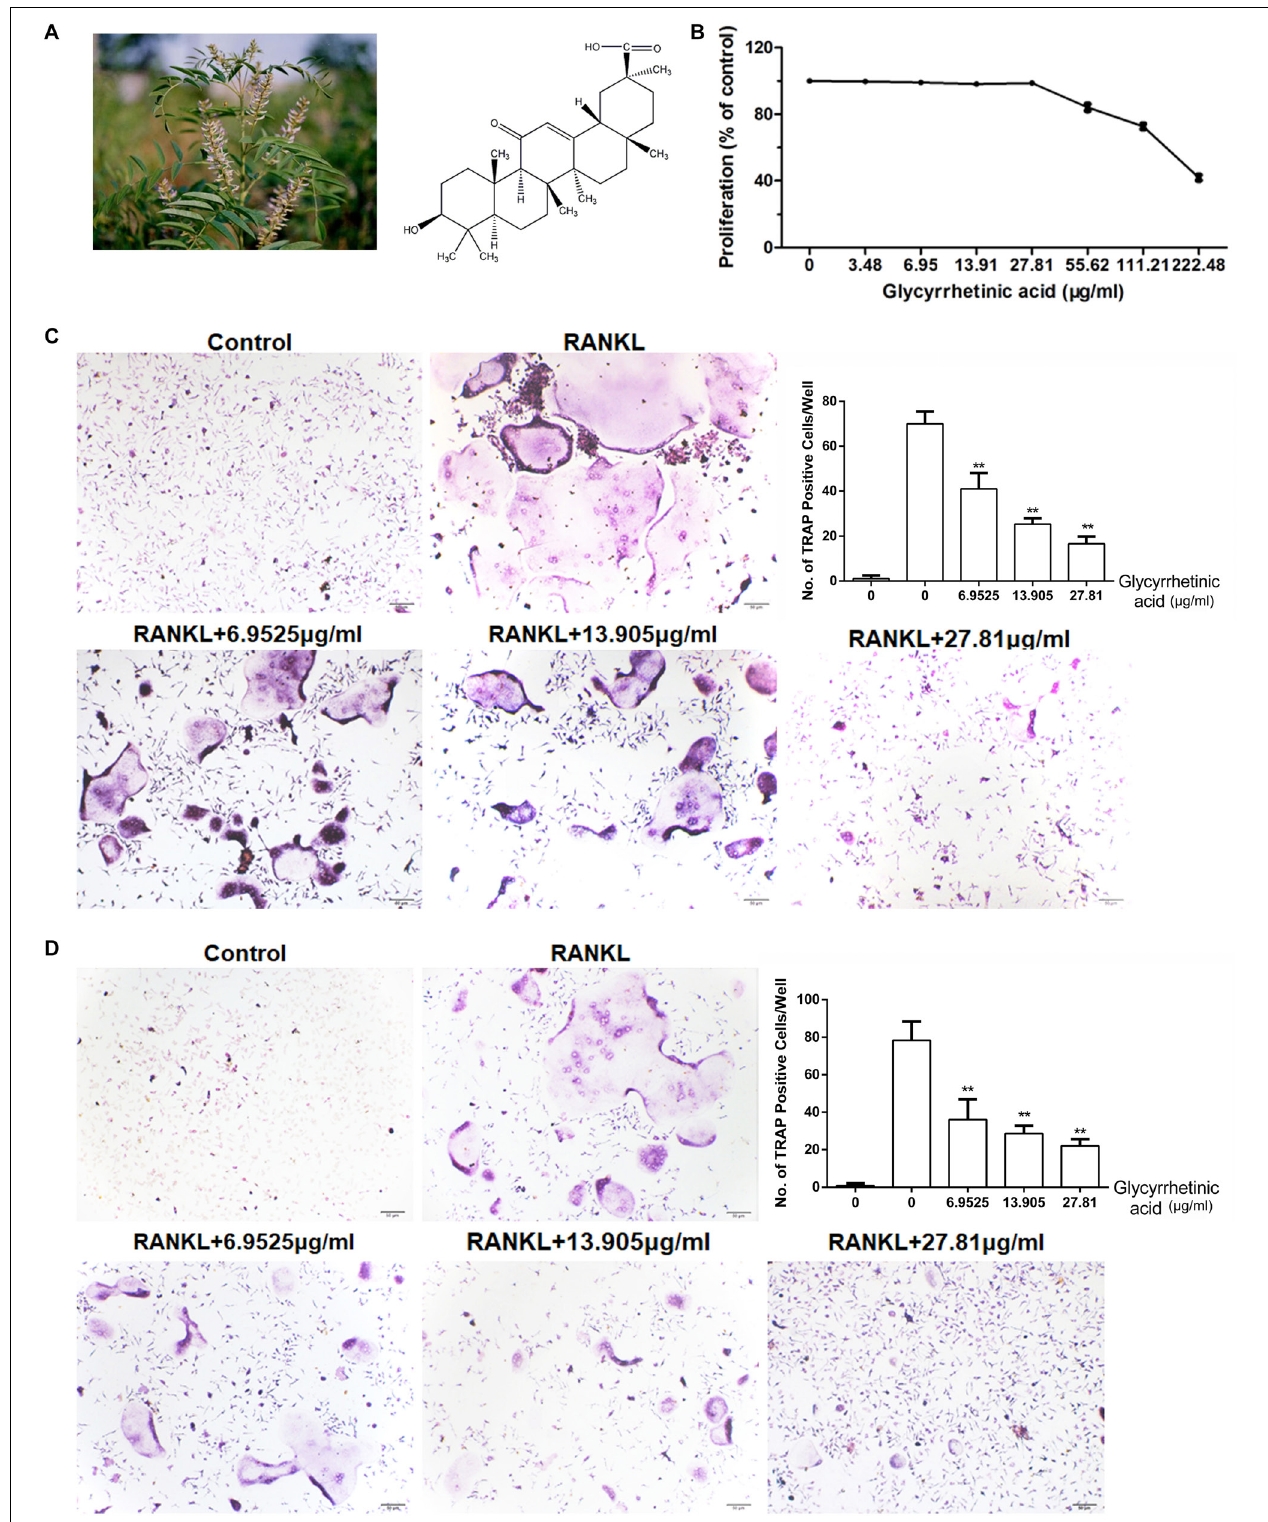
FIGURE 1 | 18 β -GA inhibits osteoclastogenesis in vitro . All the experiments were performed six times and the average was taken. (A) Chemical structure of 18 β -GA. (B) MTT analysis of 18 β -GA cytotoxicity in BMSCs. (C) Formation of TRAP-positive cells from BMMs and quantification of osteoclast. (D) Formation of TRAP-positive cells from RAW264.7 cells and quantification of osteoclast ( ∗∗ P < 0.01).